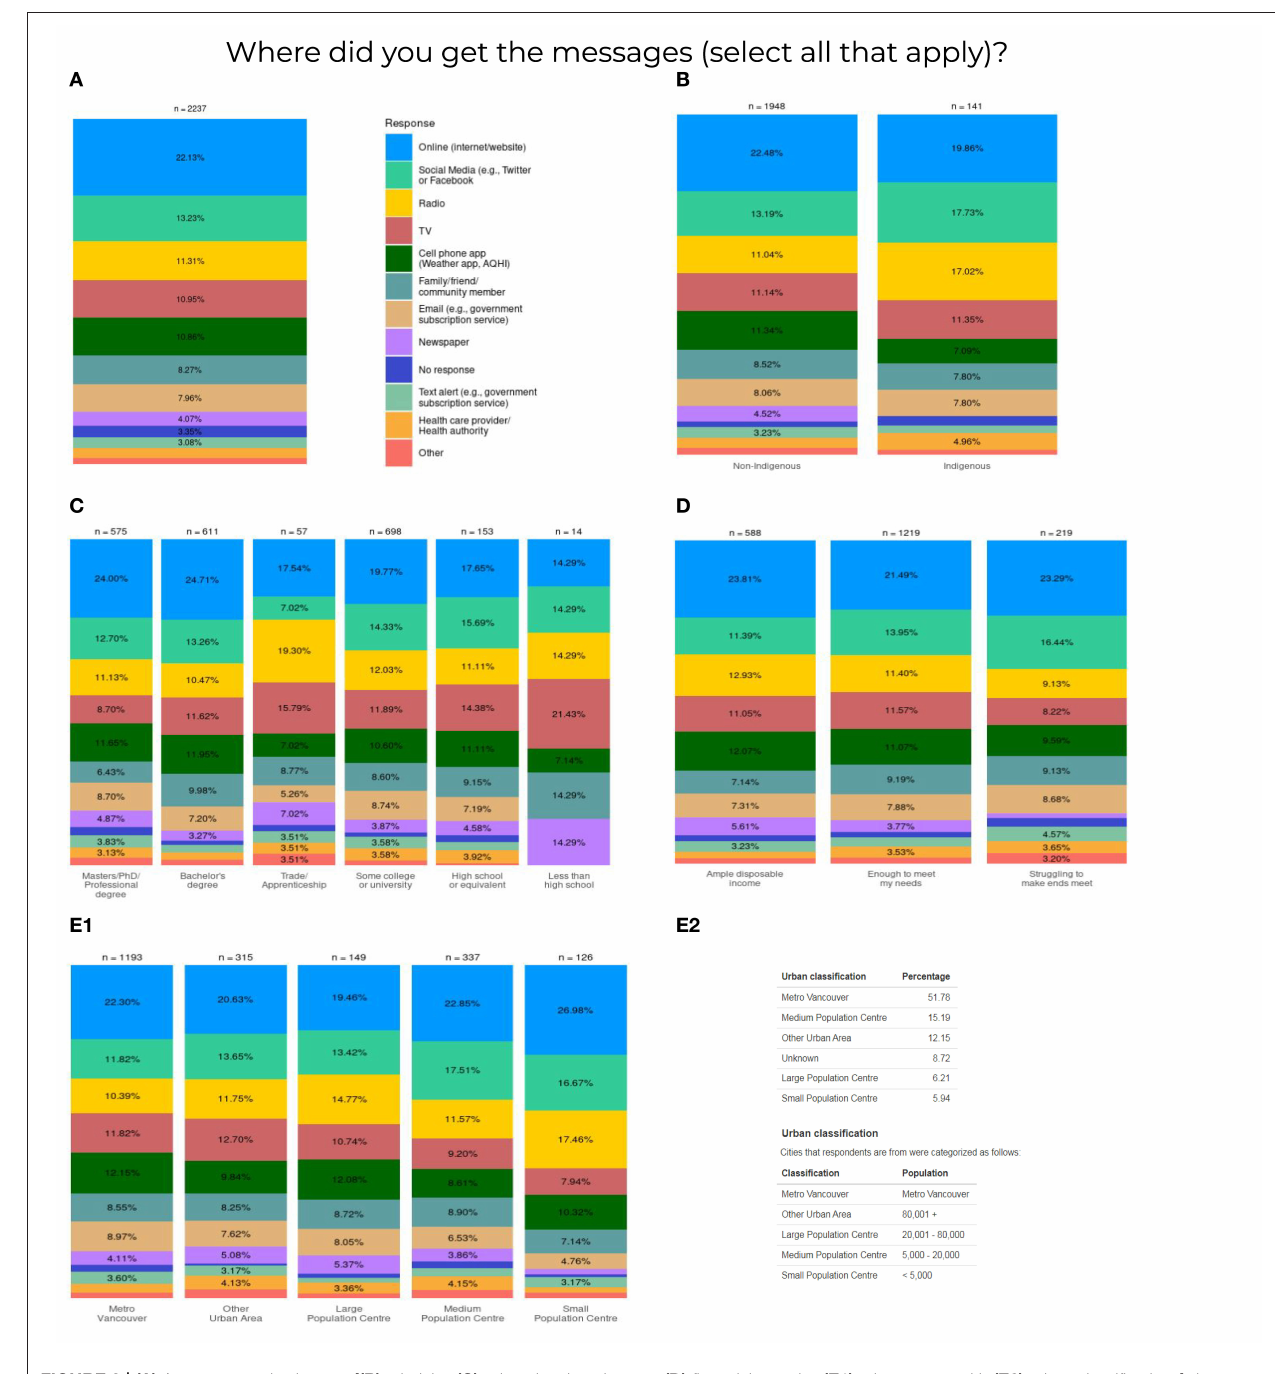
FIGURE 3 | (A) Aggregate and subgroup [ (B) ethnicity, (C) educational attainment, (D) financial security, (E1) urban status with (E2) urban classifications] data representation on where survey respondents get information related to wildfire smoke